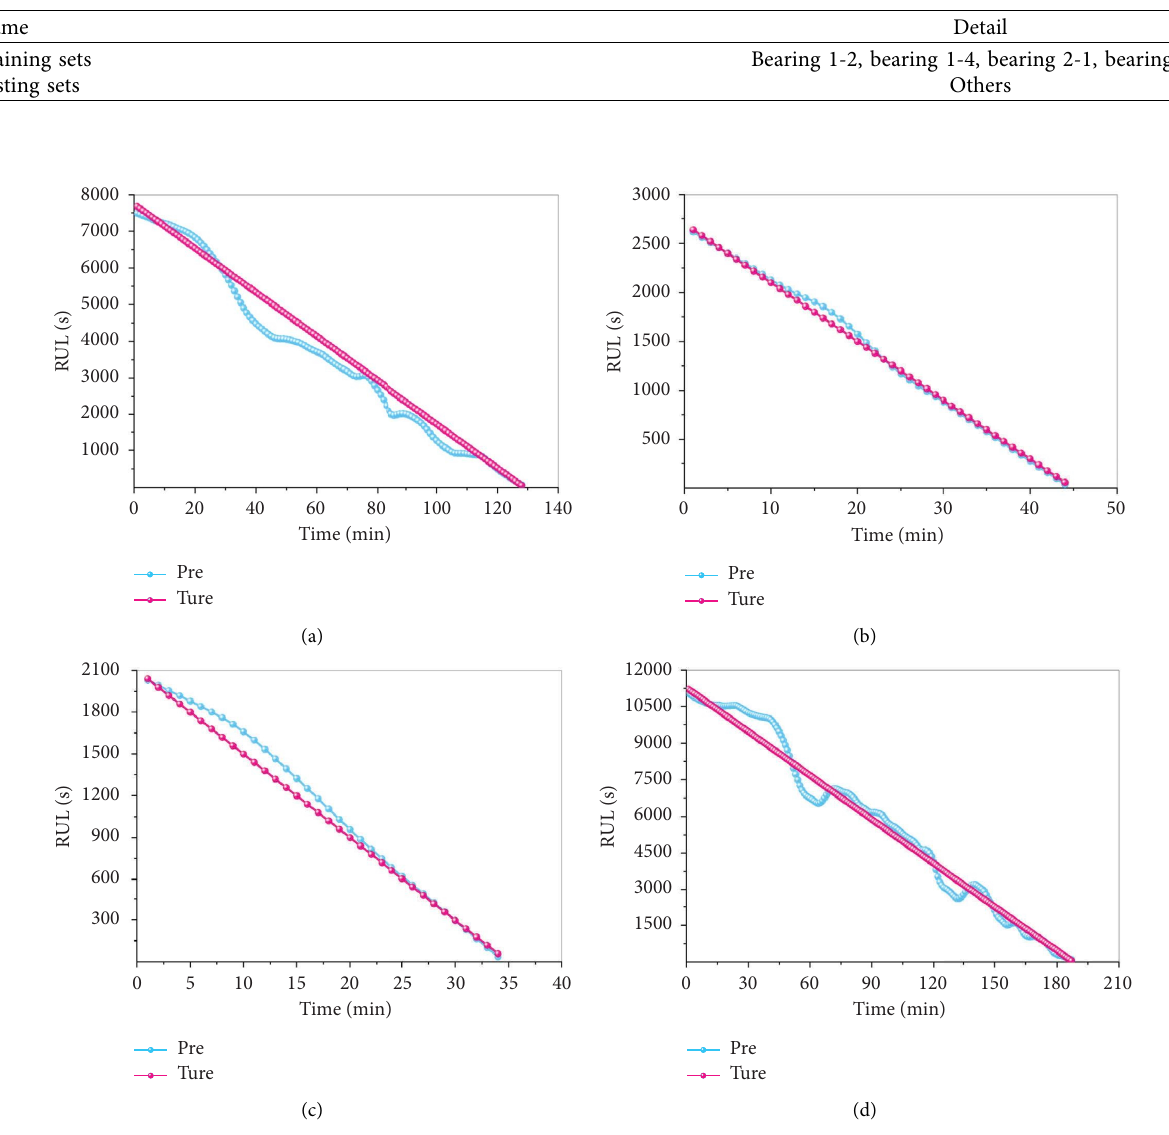
Table 4: Training and testing set data division.